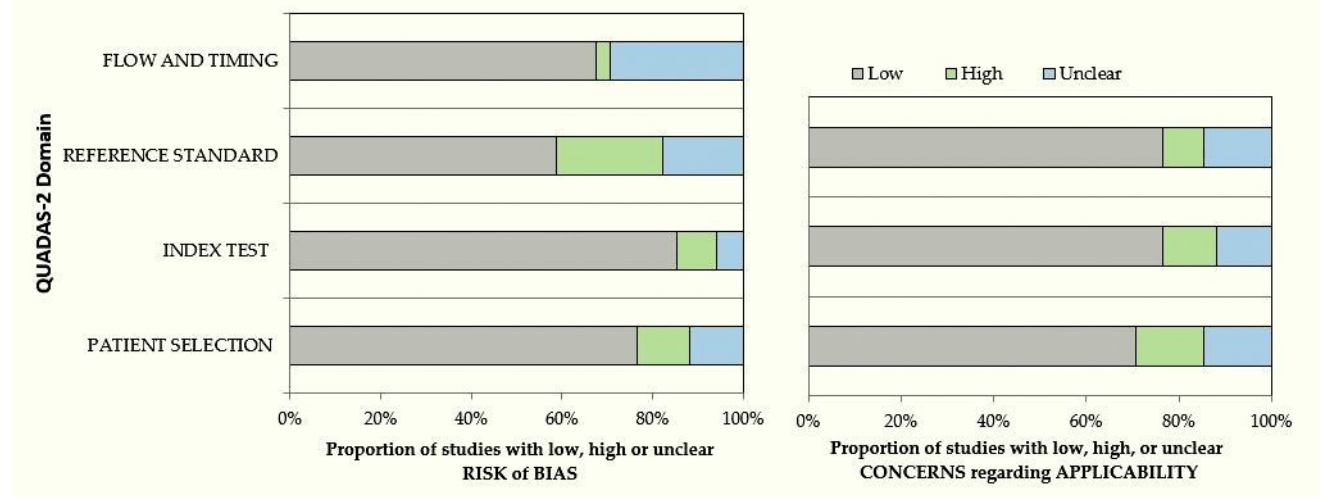
Figure 2. QUADAS-2 assessment of the individual risk of bias domains and applicability concerns.